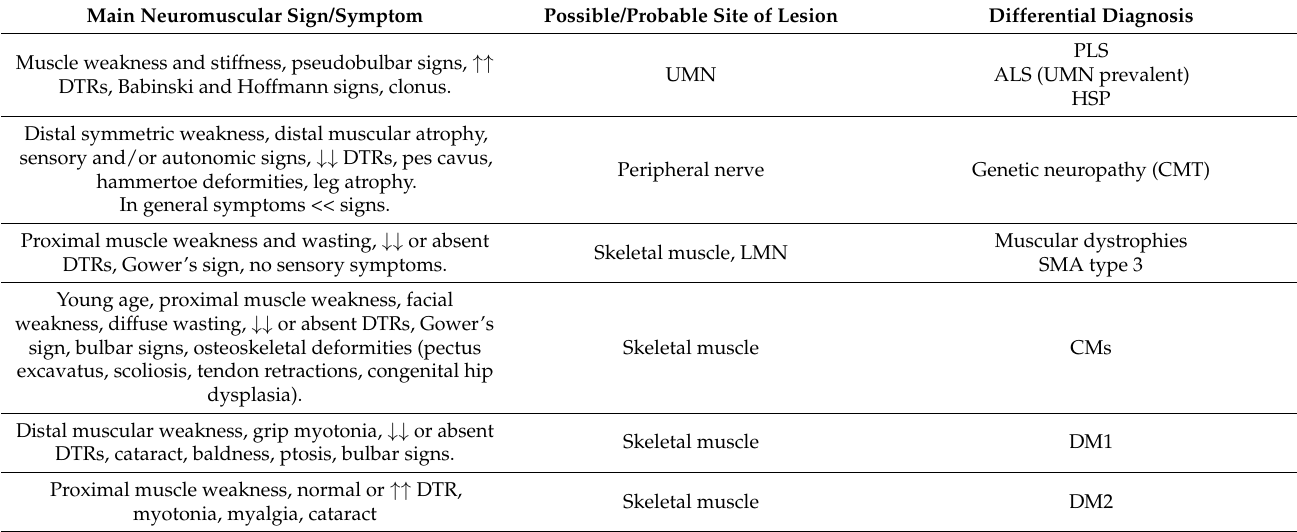
Table 2. Main clinical findings and corresponding neuromuscular site of involvement, which can help to target the genetic